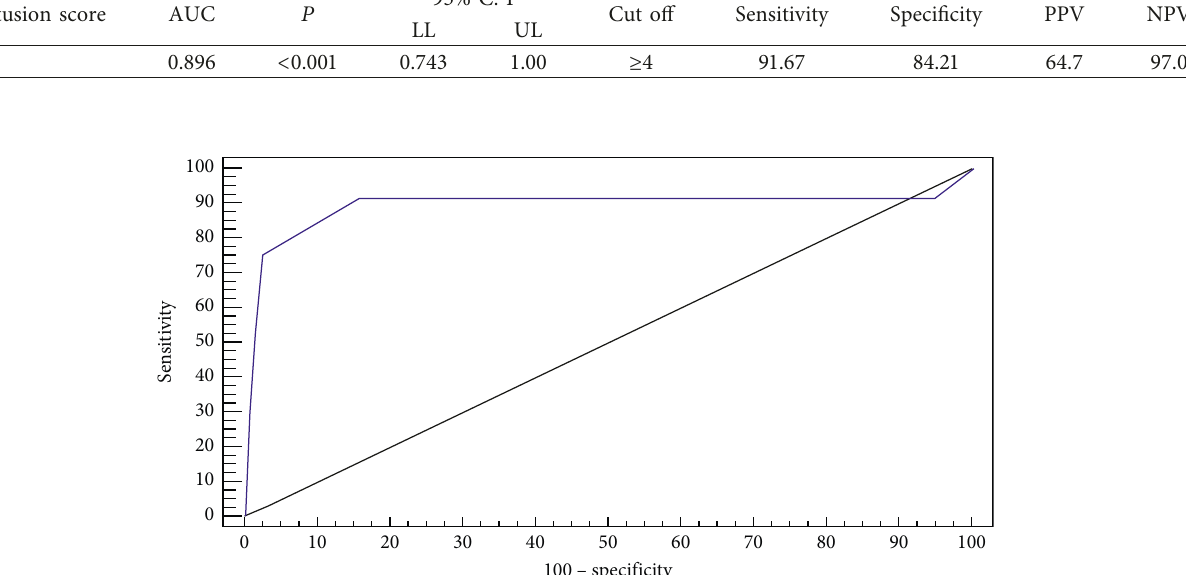
Figure 6: ROC curve for lung contusion score to predict